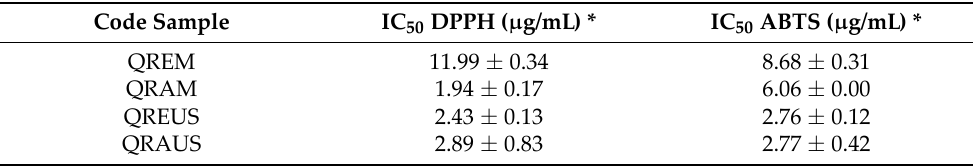
Table 2. The values of IC 50 for antioxidant activity of the oak bark